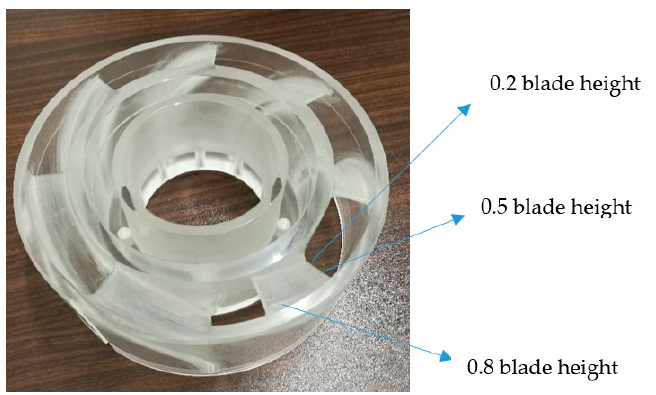
Figure 8. Diagram of different blade heights. In Figures 9–17, the color change from blue to red indicates the trend of velocity change from small to large.